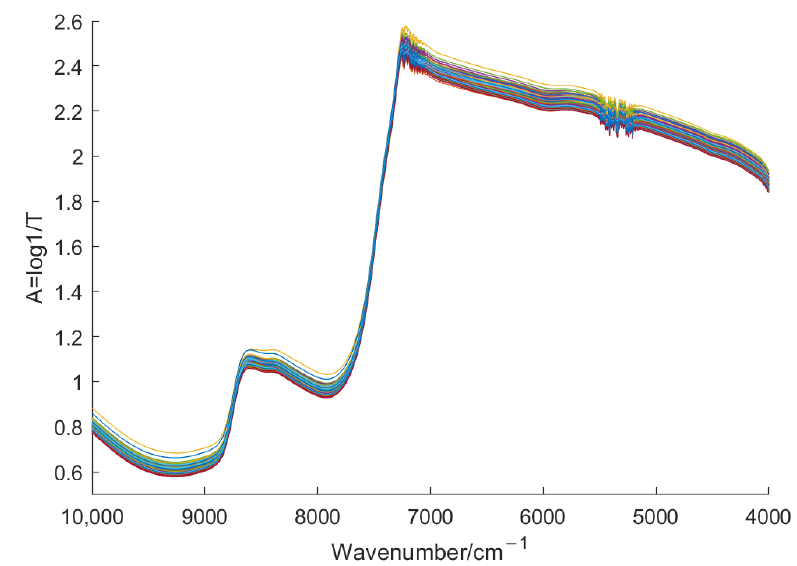
Figure 1. Original spectra of Huangshan Maofeng tea.